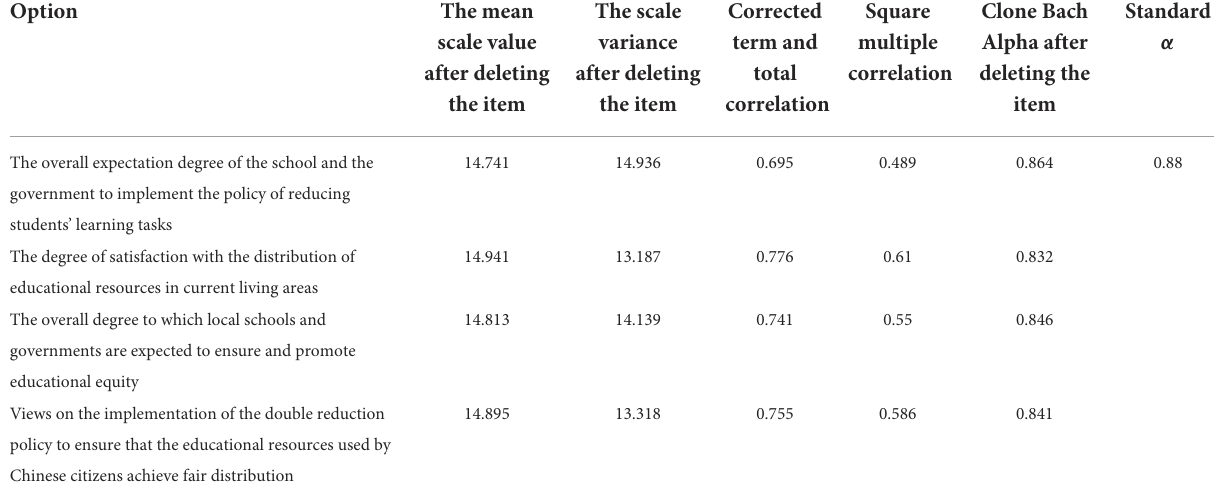
TABLE 2 Views on whether educational resources can be fairly distributed under the double reduction